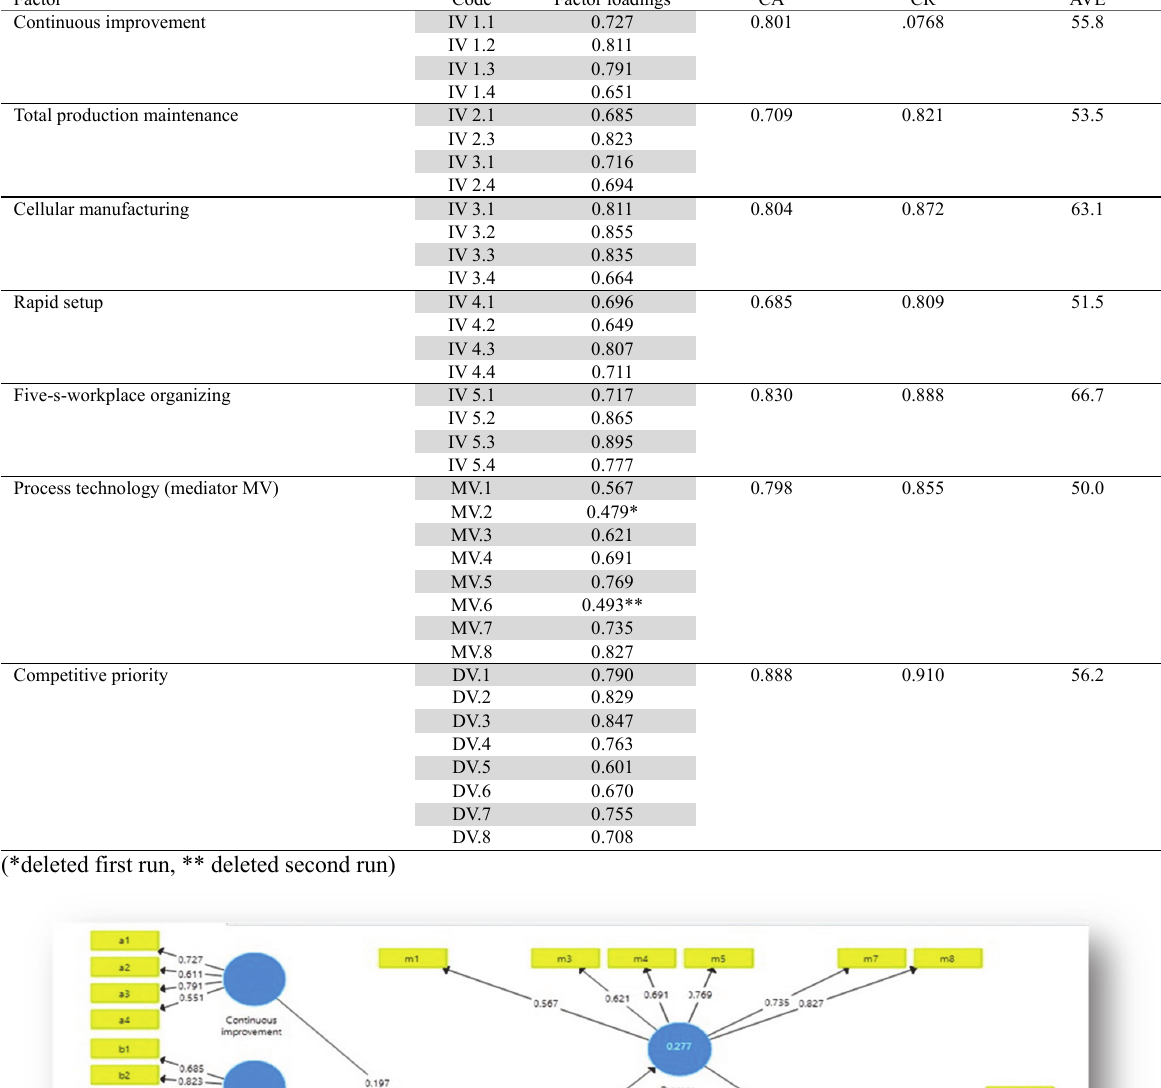
Convergent validity and reliability analysis results Composite (CR) and Cronbach Alpha (CA) using Confirmatory Factor Analysis (CFA)